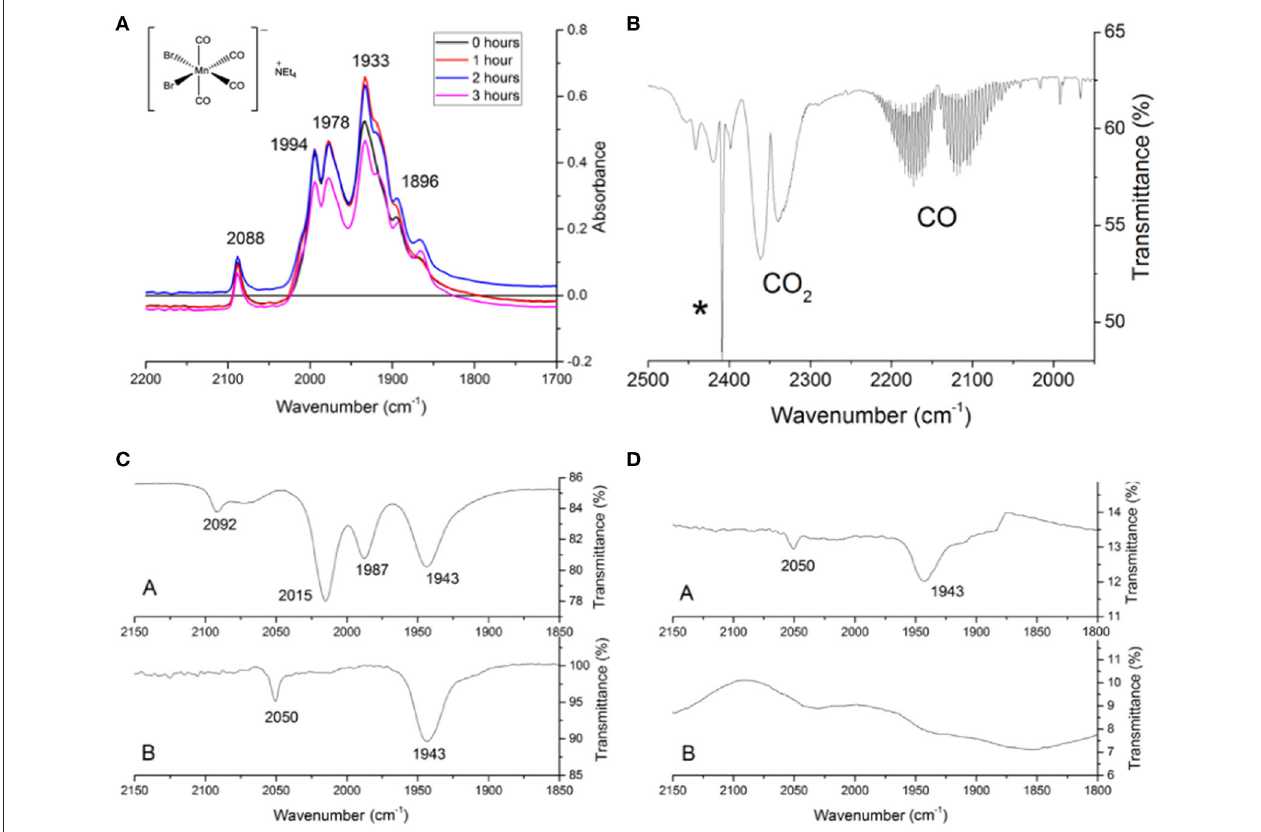
FIGURE 1 | The stability of EBOR-CORM-1. (A) shows the IR spectra of EBOR-CORM-1 upon heating at 50 ◦ C for 0h (black line), for 1h (red line), for 2h (blue), and for 3h (pink). The structure of the EBOR-CORM-1 is shown in inset on the left. (B) shows the gas phase IR spectra obtained from EBOR-CORM-1 in chloroform with added water where the * indicates a band from chloroform. (C) shows the IR spectra of EBOR-CORM-1 in chloroform (top) and water (bottom) and (D) the IR spectra of CO in water after 1min (top) and 90min (bottom) dissolution. All wavenumbers are given in cm − 1 .